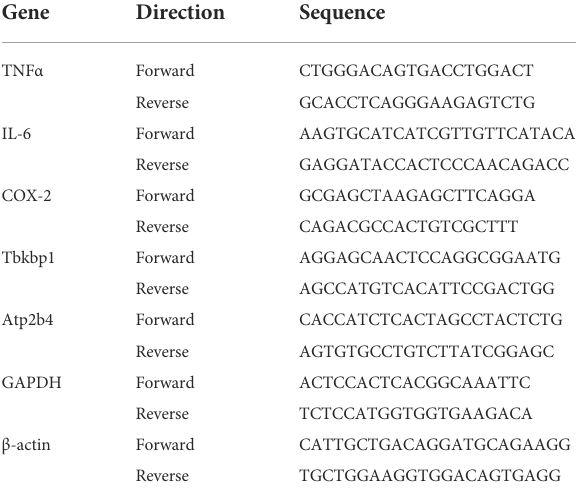
TABLE 1 List of mouse-speci fi c primers used in the